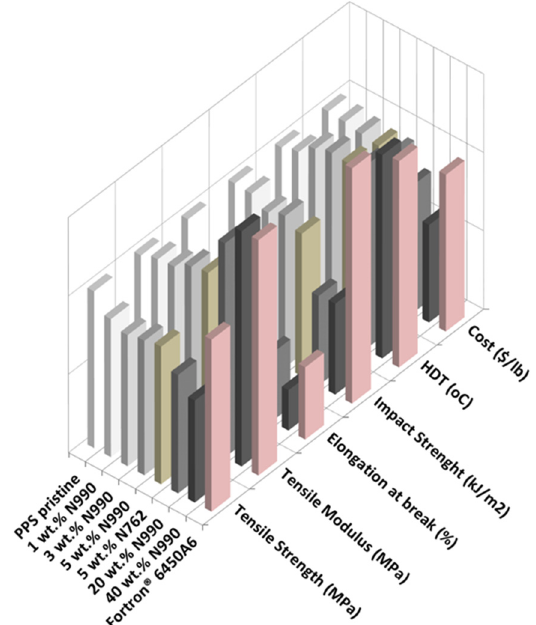
Figure 7. Comparison of tensile properties, impact properties, HDT, and materials costs of PPS/TB N990 composites from this work and PPS/40 wt. % minerals, a commercial automotive grade. Table 4. Properties (and SD) of PPS/TB N990 composites. The tensile modulus (TM) of PP / TB N990 composites highly increased with TB concentration. The TM increment was about 28% for PP / 5 wt. % TB N990, 67% for PP / 20 wt. % TB N990, and about 147% for PP / 40 wt. % TB N990 (Table 2). The value of the elongation at break at low TB N990 concentrations was preserved compared to pristine PP (around 900%) and abruptly decreased at 20 wt. % TB N990 content (down to